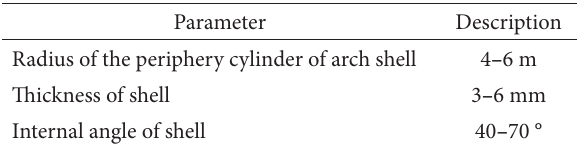
Table 2. Geometric parameters of the studied